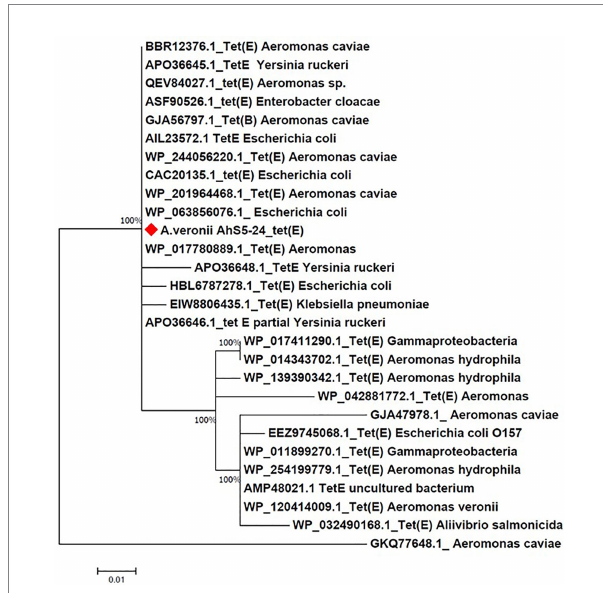
FIGURE 5 Phylogenetic tree comparing the tet(E) gene from different bacteria species. Note that the tet(E) Aeromonas veronii strain AhS5-24 had 100% similarity with tet(E) genes from other bacteria species that include Aeromonas caviae (BBR12376.1, GJA56797.1, and WP/244056220.1 and WP_20964468.1), Yersinia ruckeri (Apo036645.1, APO36646.1, and APO36648.1), Enterobacter cloacae (ASF90526.1), Escherichia coli (AIL23572.1, CAC20135.1, WP_063856076.1 and HBL6787278.1), and Klebsiella pneumoniae